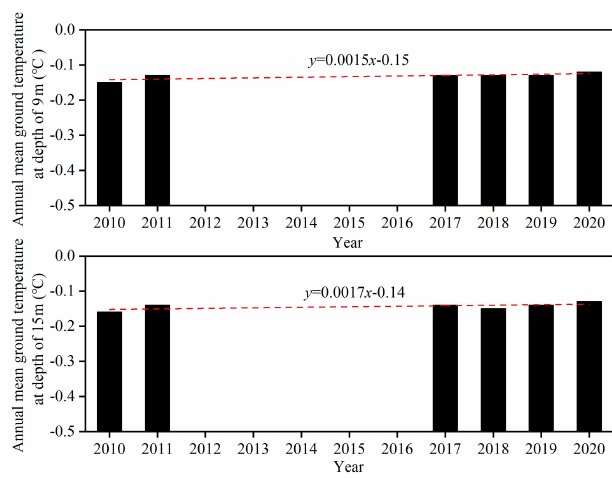
Figure 10. The annual mean ground temperature at depths of 9 and 15m during 2010–2020 at the permafrost